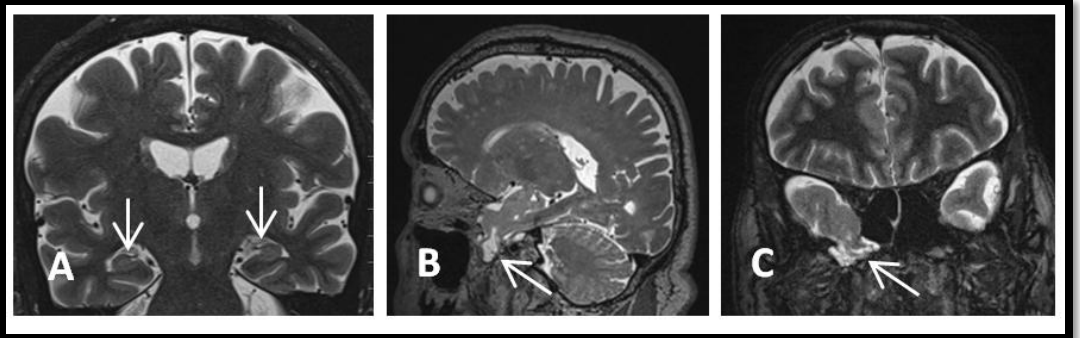
Figure 5. Preoperative brain MRI. ( A ) Coronal T2 sequence showing symmetrical bilateral hippocampi (vertical arrows). Coronal and Sagittal T2 sequence ( B , C ) showing small right sphenotemporal meningocele with small encephalocele and focal encephalomalacia of the inferior right temporal cortex (arrows).